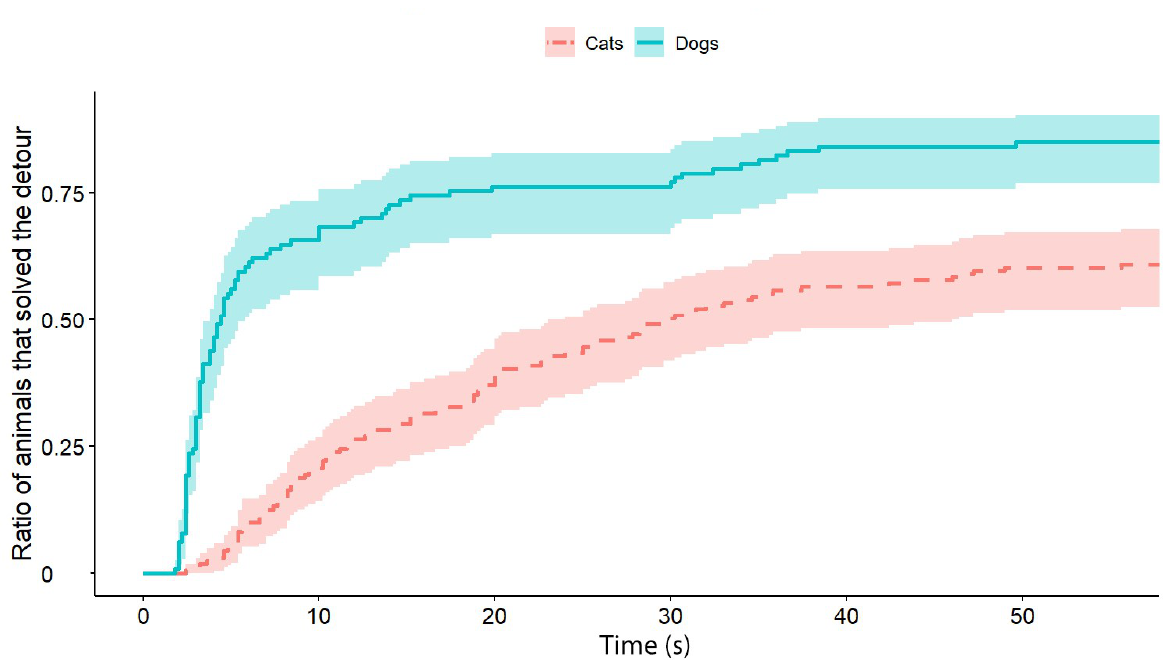
Figure 2. The latency of detours by the cats and dogs (each experimental group, with all Trials together). The latencies of successful detours are indicated on the horizontal axis, and the vertical axis shows the proportion of subjects (cats and dogs separately) that successfully solved the task with a given latency.